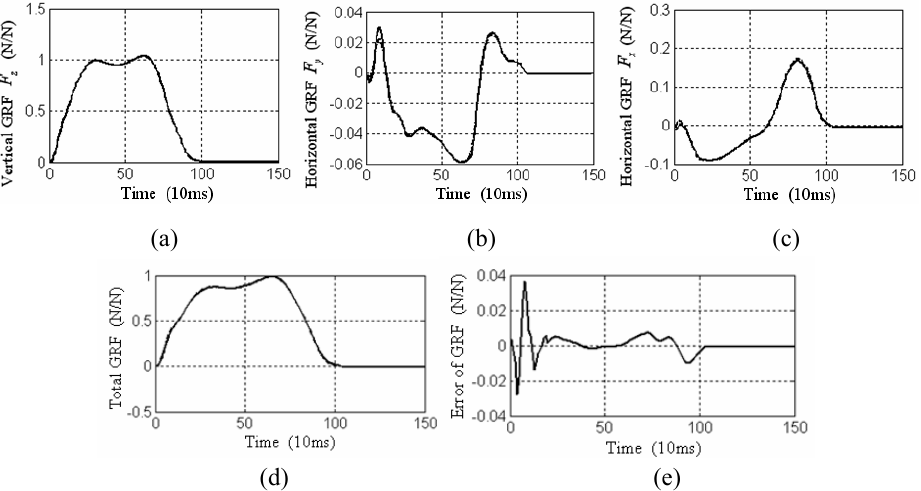
Fig. 2. GRF measured by wearable sensor systems (solid line) and force plate (dashed line). F . (b) Horizontal components, (a) Vertical components, z F . (d) Total GRF. (e) Error of GRF between two x